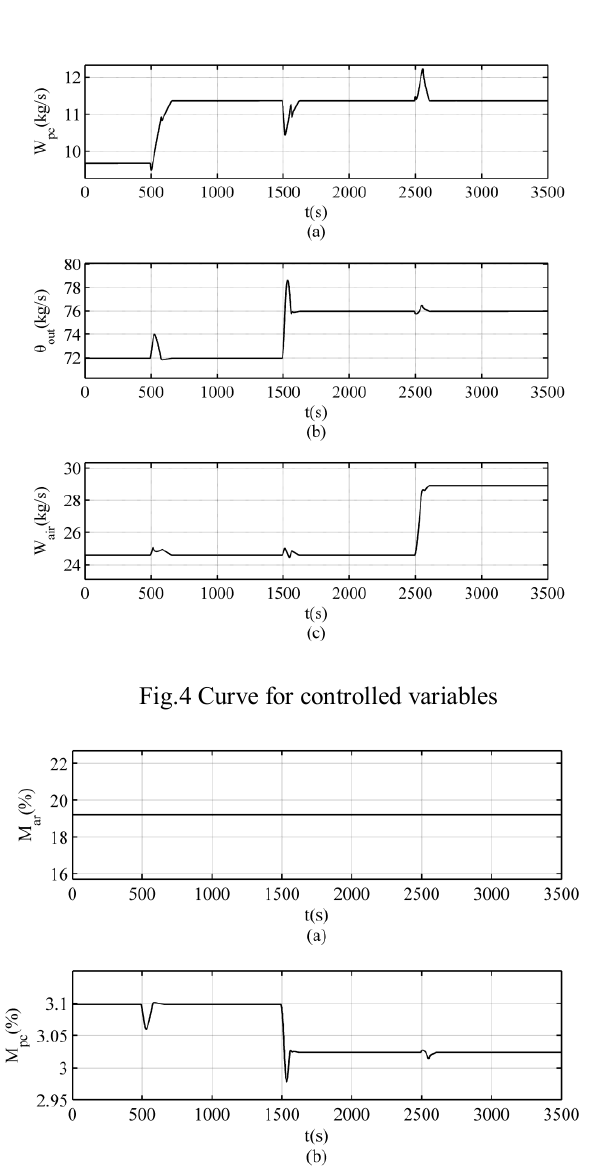
Fig.5 Moisture of Raw coal and coal